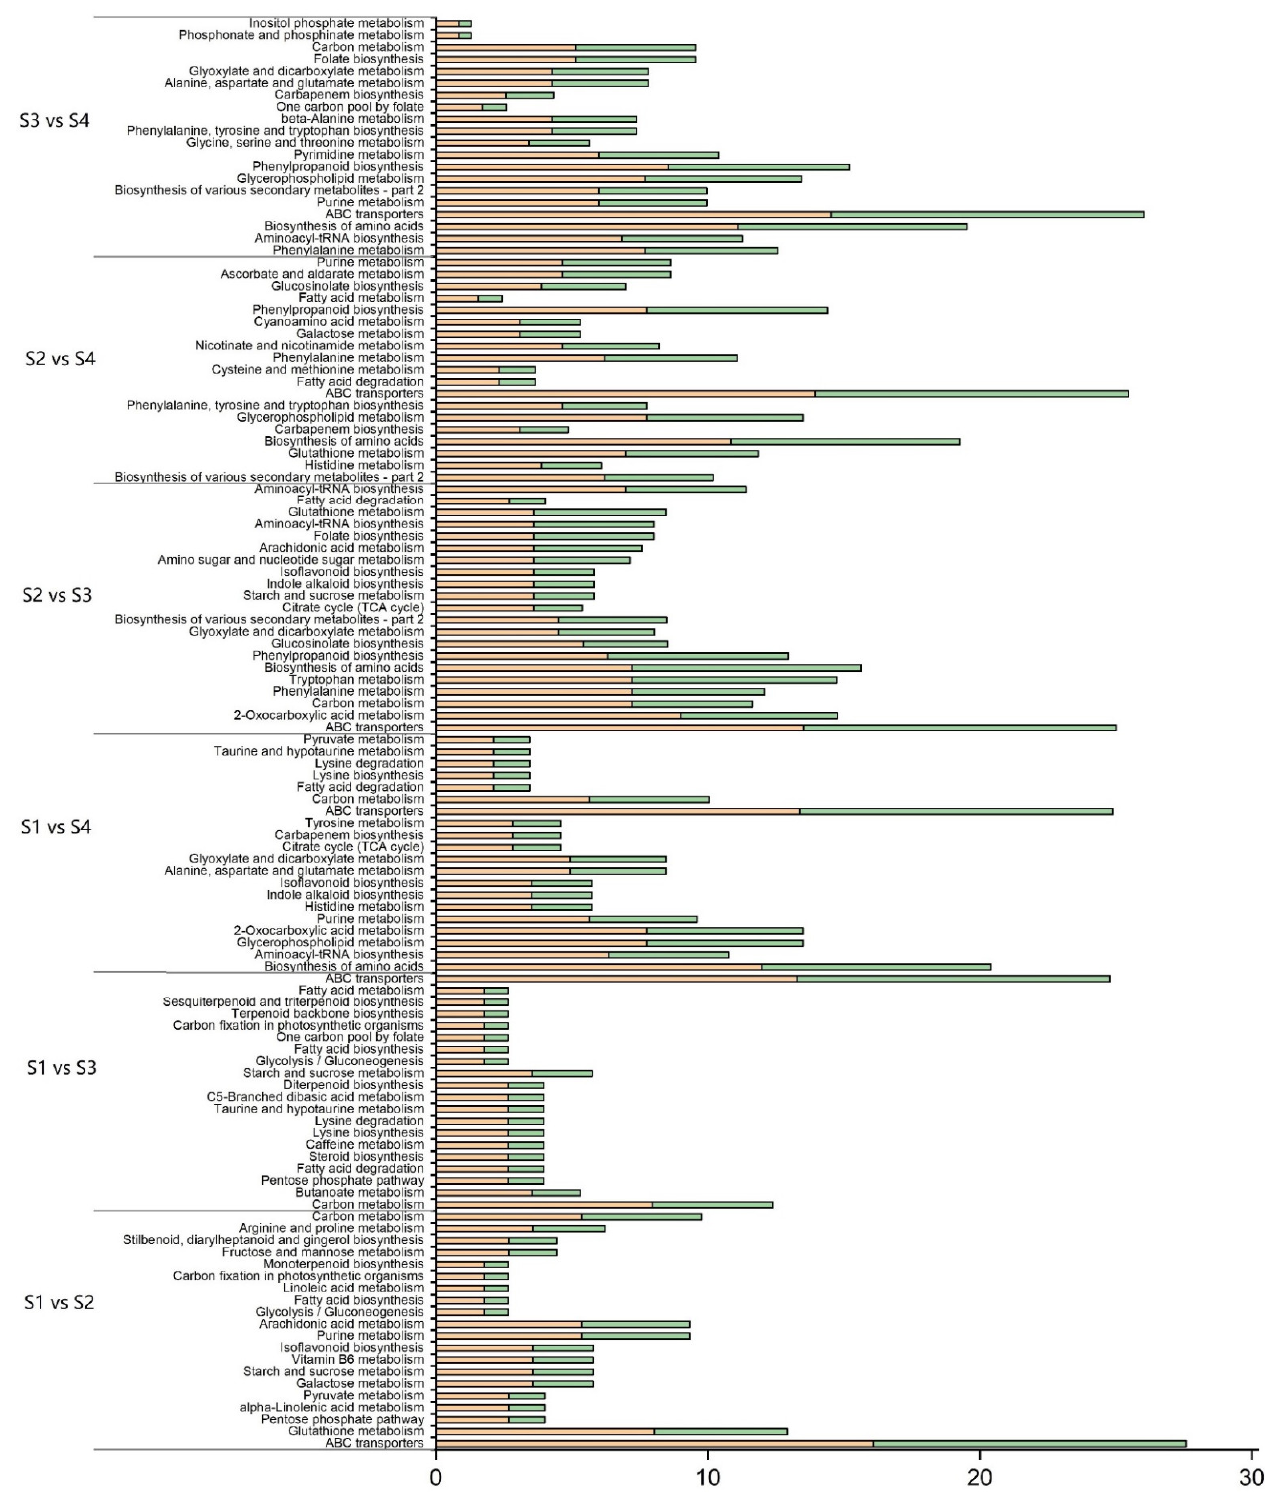
Figure 7. The top 20 enrichment KEGG pathways were represented. The vertical axis is the name of the KEGG metabolic pathway and the horizontal axis is the number of metabolites and its proportion to the total number of annotated metabolites to the pathway. The orange bar represents the percentage of differential metabolites associated with each pathway among all differential accumulated metabolites; the green bar represents all differential metabolites of each pathway.